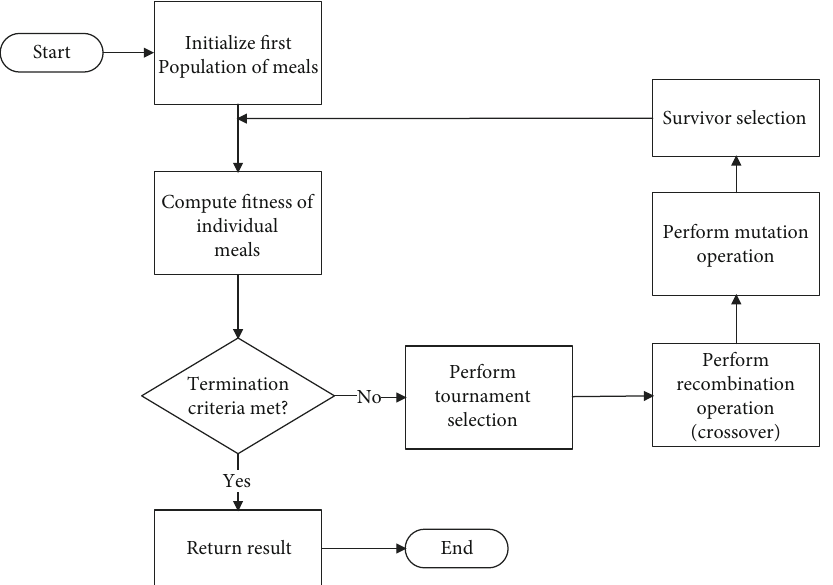
Figure 3: General fl ow diagram for genetic algorithm